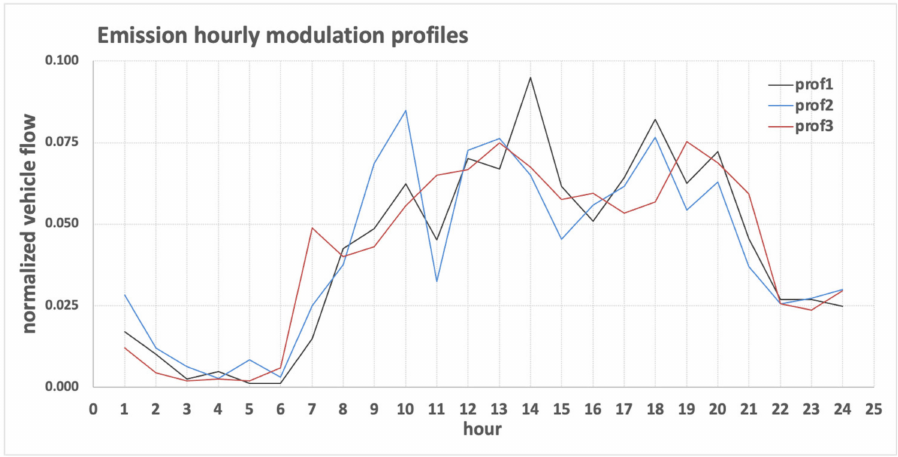
Figure 4. Vehicle flow modulation profiles used in